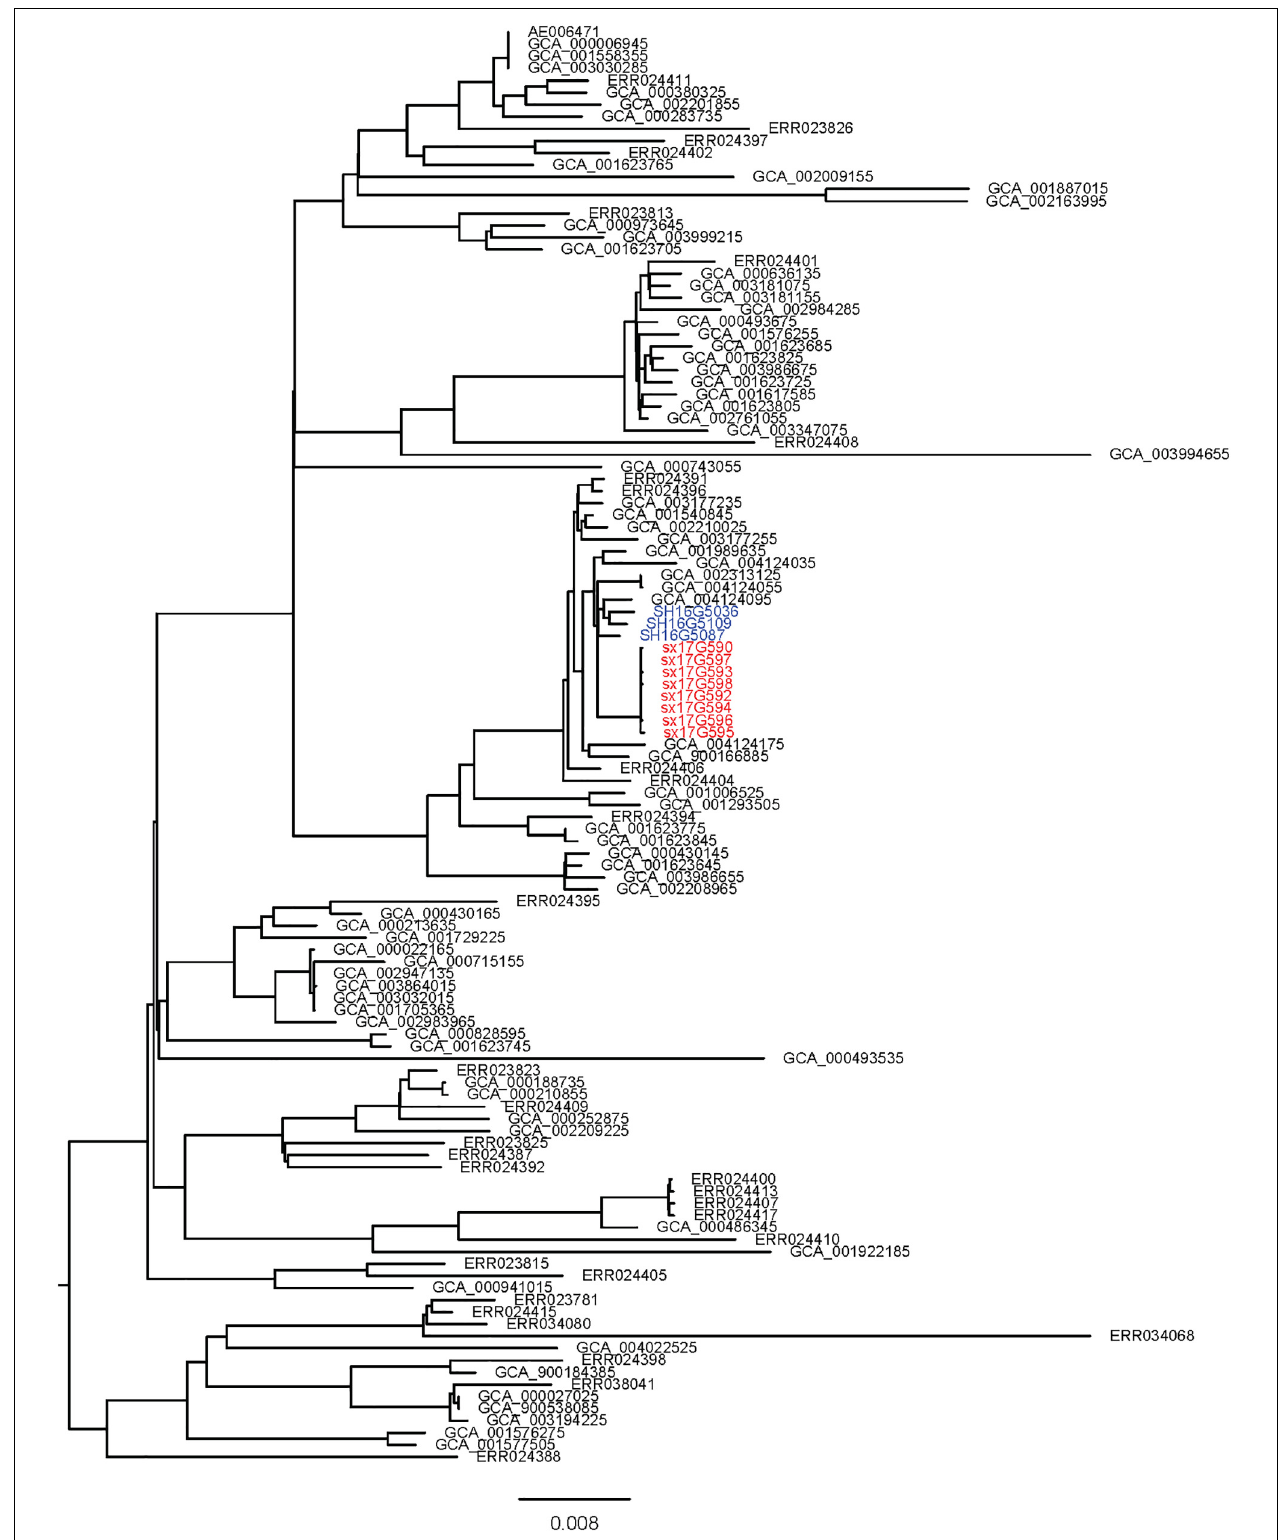
FIGURE 2 | Sub-branch of the outbreak strains. Outbreak strains isolated in this study were marked in red color, and strains kept in our laboratory were marked in blue color.